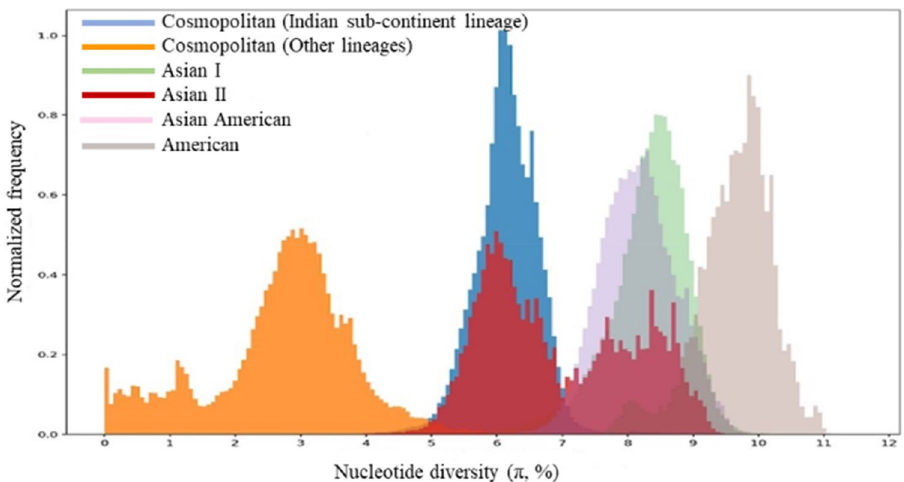
Figure 5. Pairwise nucleotide diversity (π index) comparison between cosmopolitan (Indian sub-continent lineage and other lineages) and other known genotypes of DENV-2. Each colour represents a different genotype of DENV-2.